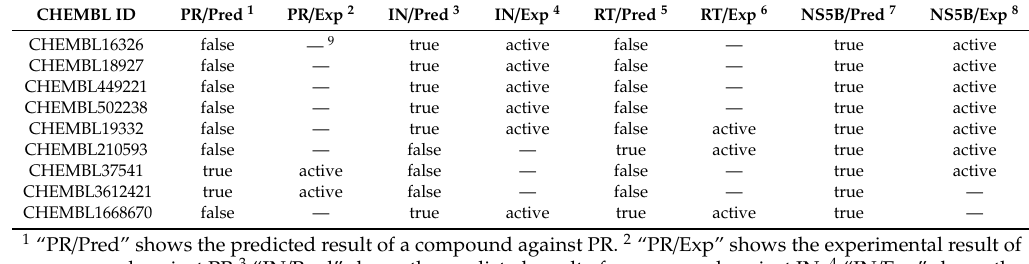
Table 5. Predicted and experimental activity of the nine selected compounds against HIV-1 protease (PR), reverse transcriptase (RT), integrase (IN) and HCV NS5B. CHEMBL ID PR / Pred 1 PR / Exp 2 IN / Pred 3 IN / Exp 4 RT / Pred 5 RT / Exp 6 NS5B / Pred 7